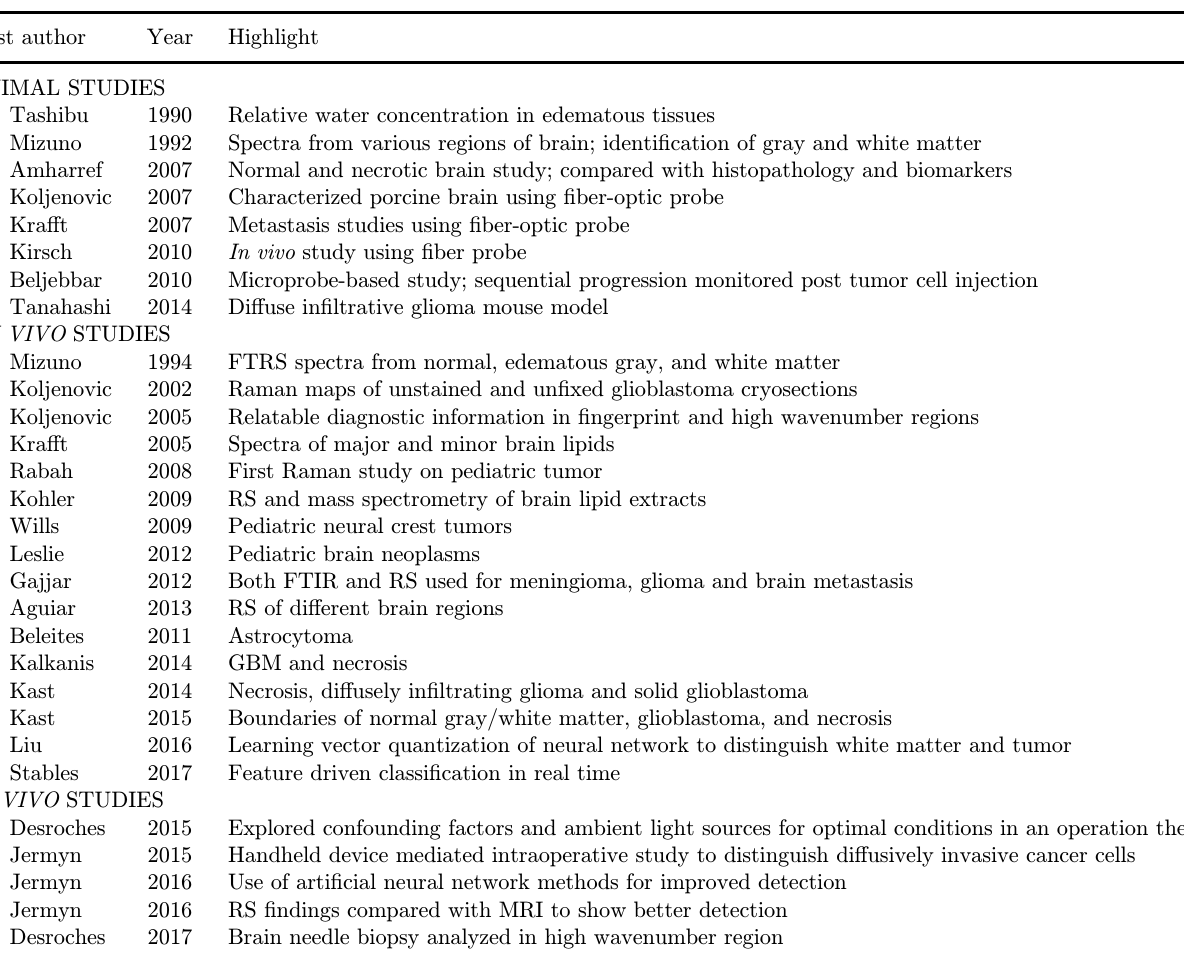
Table 1. Summary of major Raman spectroscopy-based